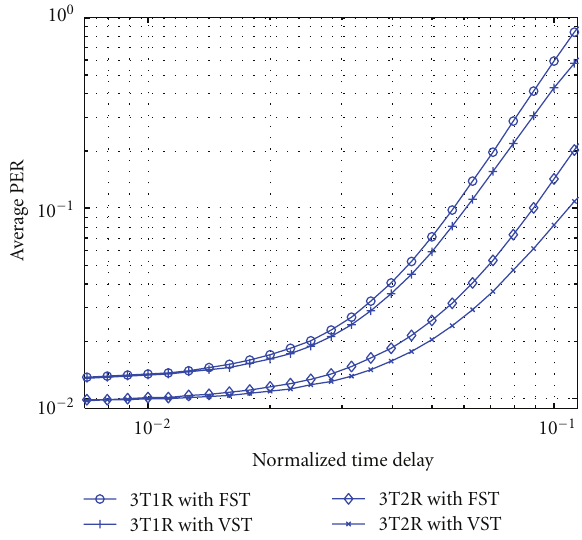
Figure 4: E ff ect of normalized time delay on average PER of CLD- AS with three transmit antennas and di ff erent receive